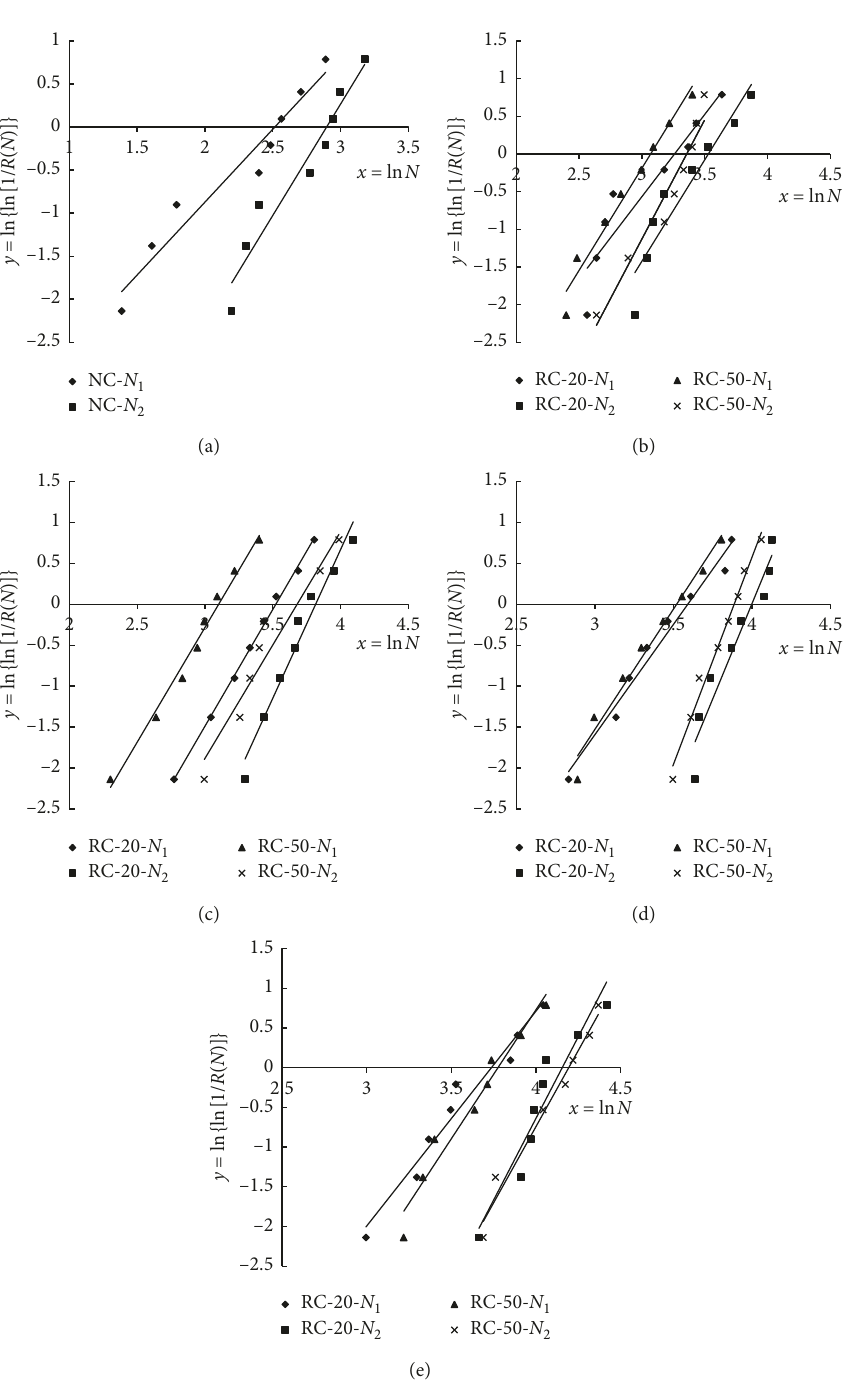
Figure 6: Weibull distributions of N for the rubber concrete specimens at − 30 ° C. Rubber powder: (a) 0%, (b) 5%, (c) 10%, (d) 15%, and (e)